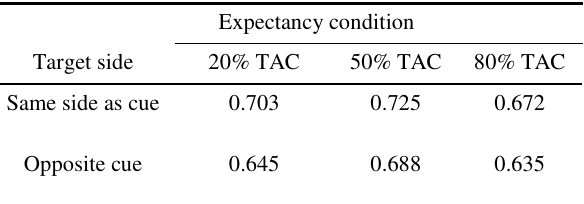
Results of Experiment 2, showing proportion correct (out of all possible responses) across the three expectancy